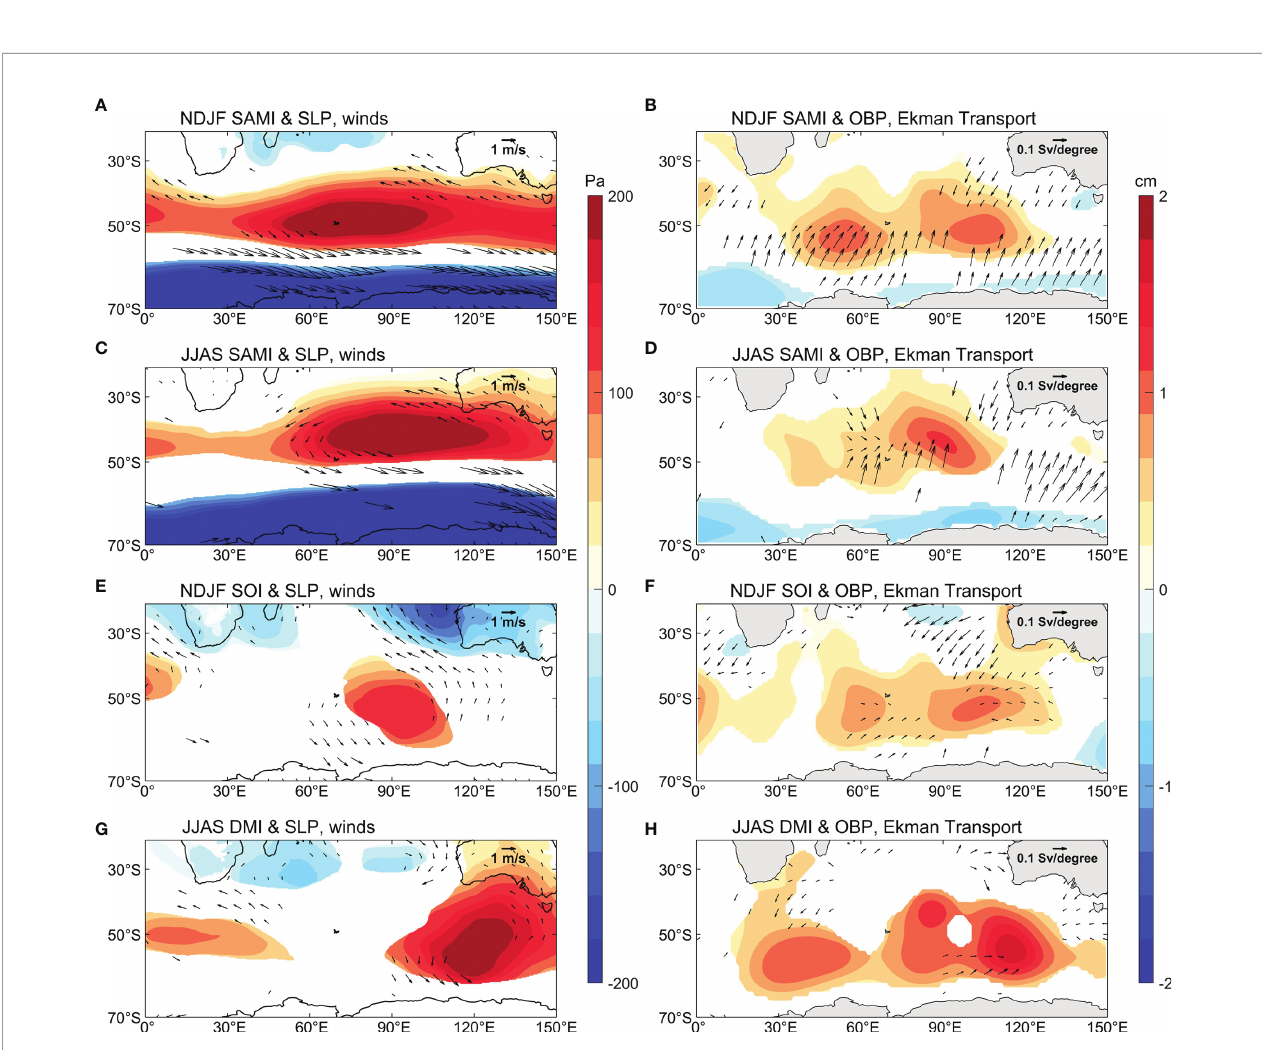
FIGURE 7 | Regression coef fi cients of SLP anomalies (color) and 10 m winds (vector) on the (A) normalized NDJF-averaged SAMI, (C) normalized JJAS-averaged SAMI, (E) normalized NDJF-averaged SOI and (G) normalized JJAS-averaged DMI. (B, D, F, H) are identical to (A, C, E, G) but for OBP anomalies (color) and Ekman transports (vector). Only anomalies signi fi cant at the 95% signi fi cance level are shown.